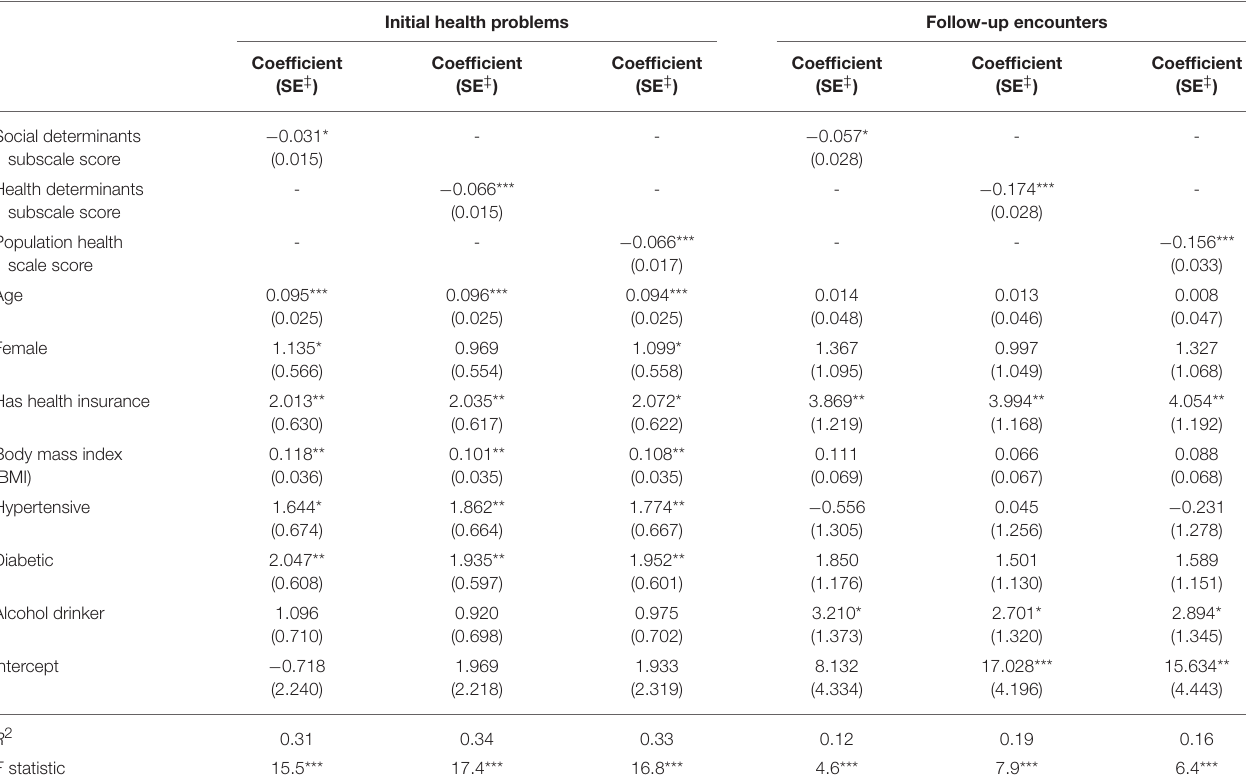
TABLE 5 | Duke-PH scores as predictors of number of initial health problems (morbidity) and number of 6-months follow-up encounters (utilization), while controlling for other variables †